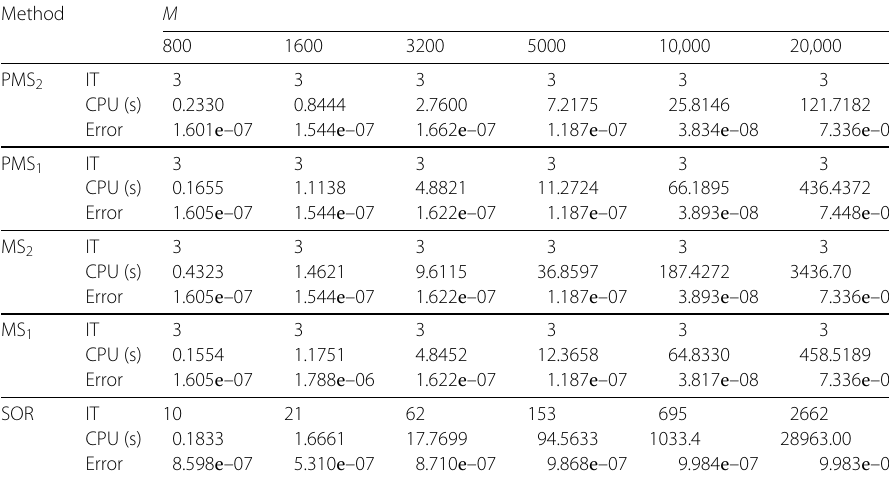
Table 1 Numerical results of the Example 1 for α =